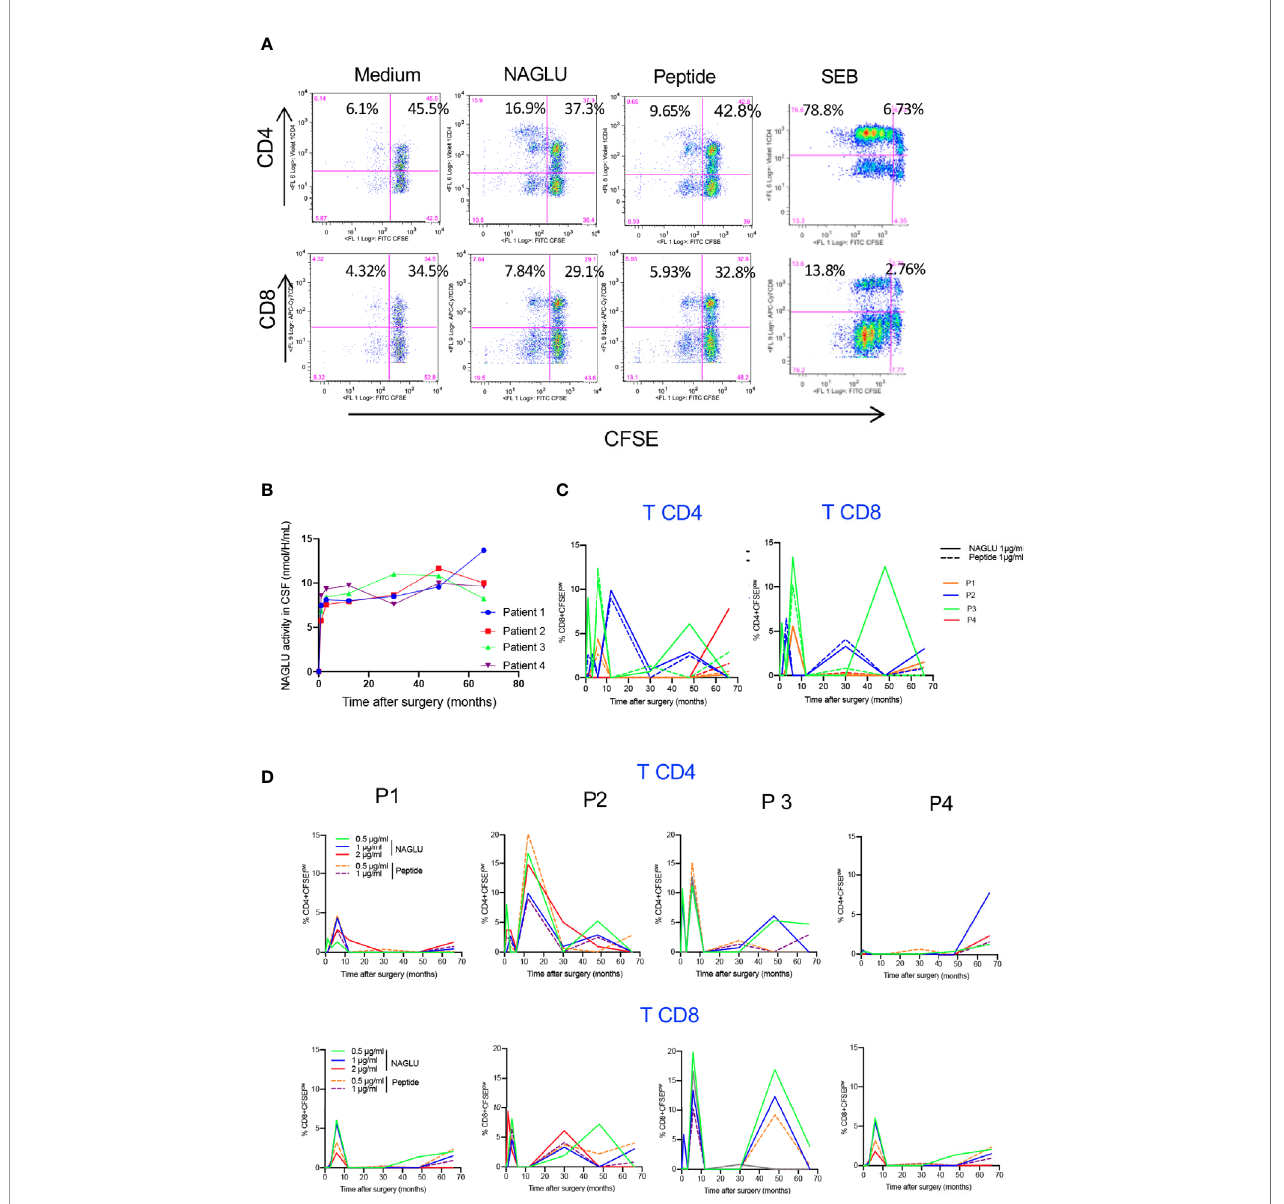
FIGURE 3 | Ex-vivo NAGLU-speci fi c proliferative response. (A) Representative fl ow charts showing the proliferation of CD4 + and CD8 + T cells on gated CD3 + T cells in response to NAGLU (1 m g/ml), NAGLU peptide (1 m g/ml), SEB (1 m g/ml), or unstimulated (medium), assessed with the CSFE assay. Freshly isolated PBMCs were stained with CFSE and stimulated for 4 days with the indicated antigens. Percentage of proliferating CFSE low cells is indicated in the quadrants. (B) Time course evolution of NAGLU catalytic activity, assessed in concentrated CSF as described in “ Patients and Methods ” . (C) The ex-vivo detection of NAGLU-speci fi c proliferating CD4 + and CD8 + T cells was assessed at baseline (BL) and 1, 3, 6, 12, 30, 48 and 66 months after surgery using the CFSE assay on freshly isolated PBMCs, stimulated for 4 days with the indicated concentrations of NAGLU or the peptide. The percentage of CFSE low proliferating cells within CD4 + and CD8 + T cells, obtained after removing the background in non-stimulated cultures, is indicated for each patient over the longitudinal follow-up. (D) Overlay of patients ’ CD4 + and CD8 + T cell proliferating responses to NAGLU and peptide at 1 m